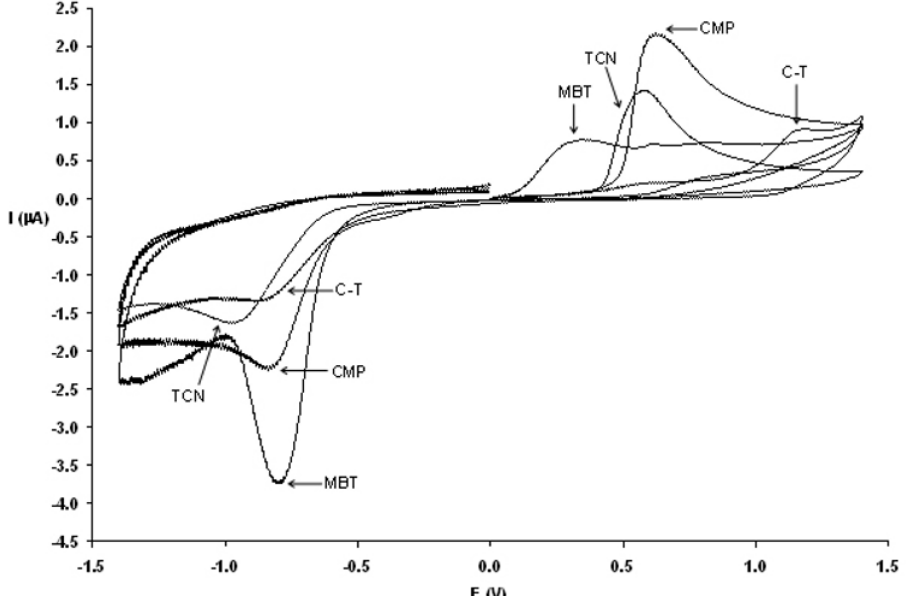
Figure 1. Cyclic voltammograms of studied disinfectants in Britton-Robinson buffer at pH 9.9: MBT - 2-mercaptobenzothiazole (896.9 µM), TCN - triclosan (518.1 µM), CMP - 4-chloro-3-methylphenol (1.05 mM), C-T - chloramine-T (658.9 µM). Scan rate: 100 mV s -1